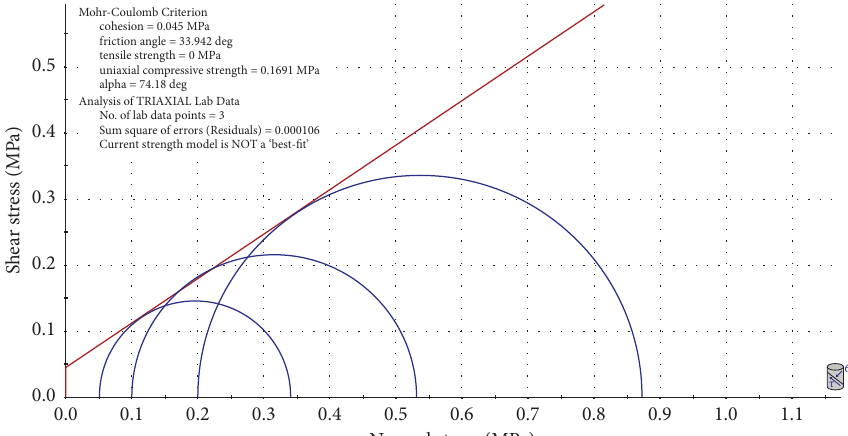
Figure 15: Shear strength variation against the normal stress-saturated condition LR8 (lime RHA 1 :2 and 8% lime content), 28 days of curing, from numerical modelling plotted by RocData.